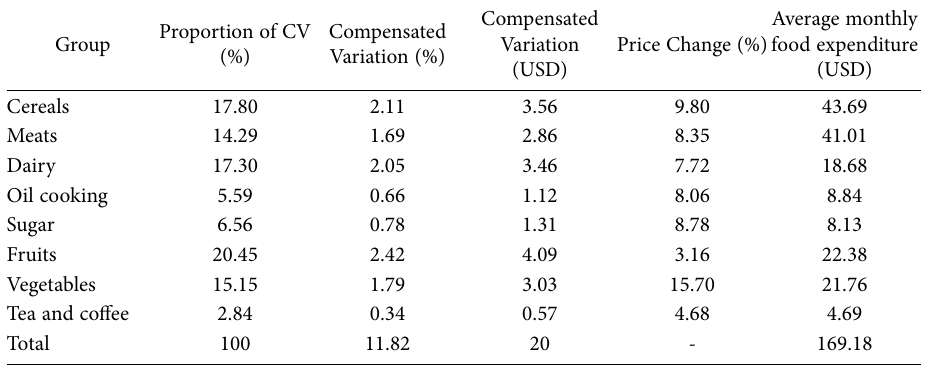
Table 3. Welfare effect of price changes(The average compensating variation values).